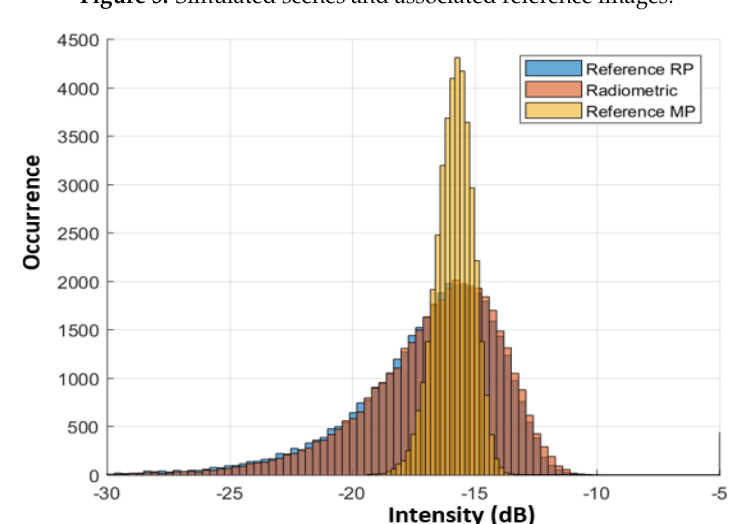
Figure 6. Histogram of radiometric scene, MP and RP FBR